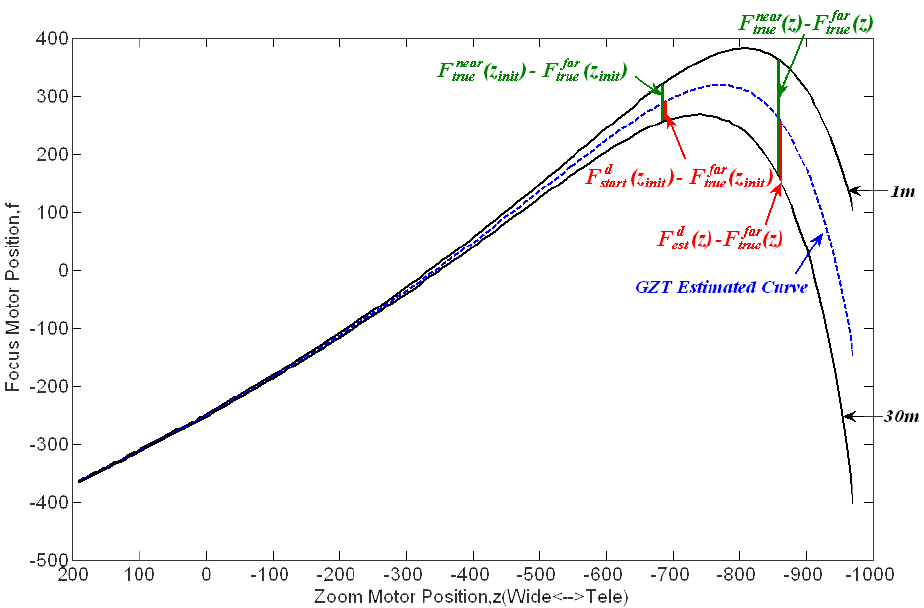
Figure 5. Illustration of the GZT focus ratio.